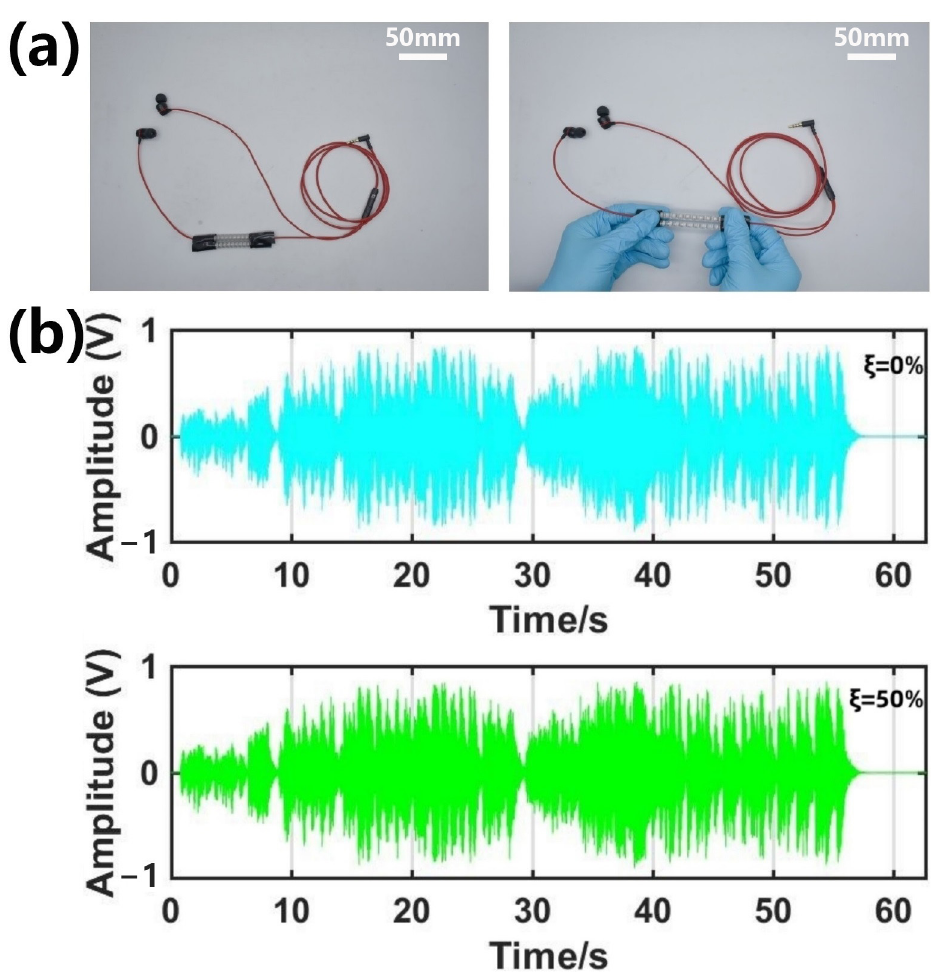
Figure 5. ( a ) Image of stretchable conductor as earphone wire. ( b ) Amplitude–time curve of complex music signals from retractable headphones.